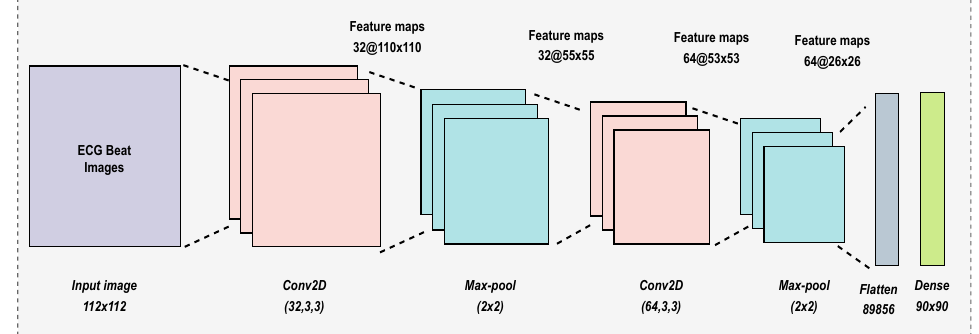
Figure 6. CNN used in the Siamese deep learning technique.